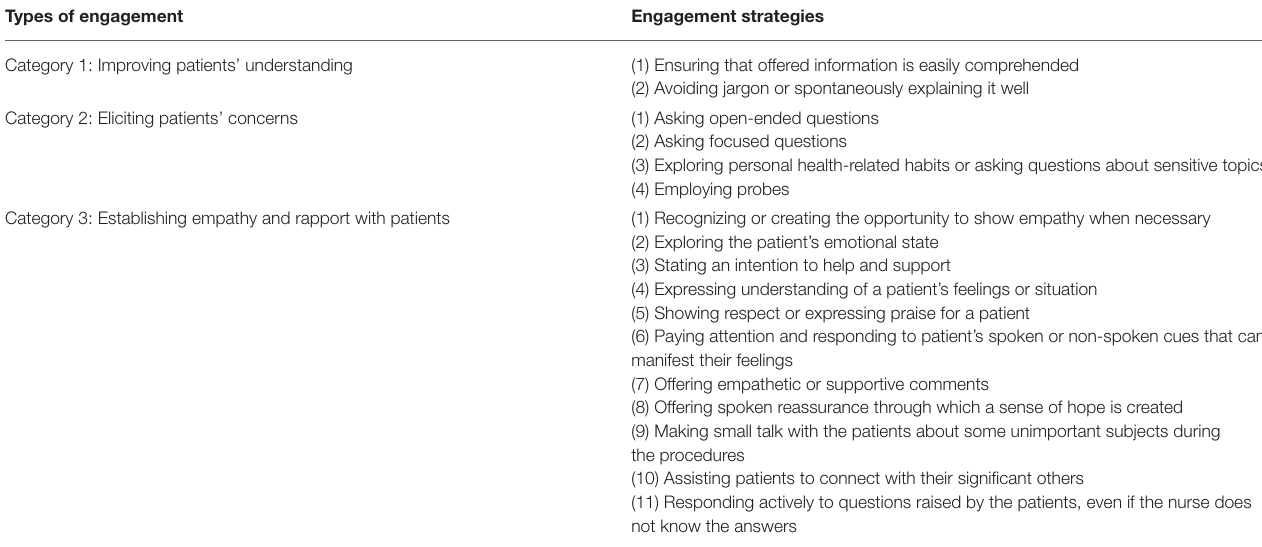
TABLE 8 | Engagement strategies identified from nurses’ interviews. Types of